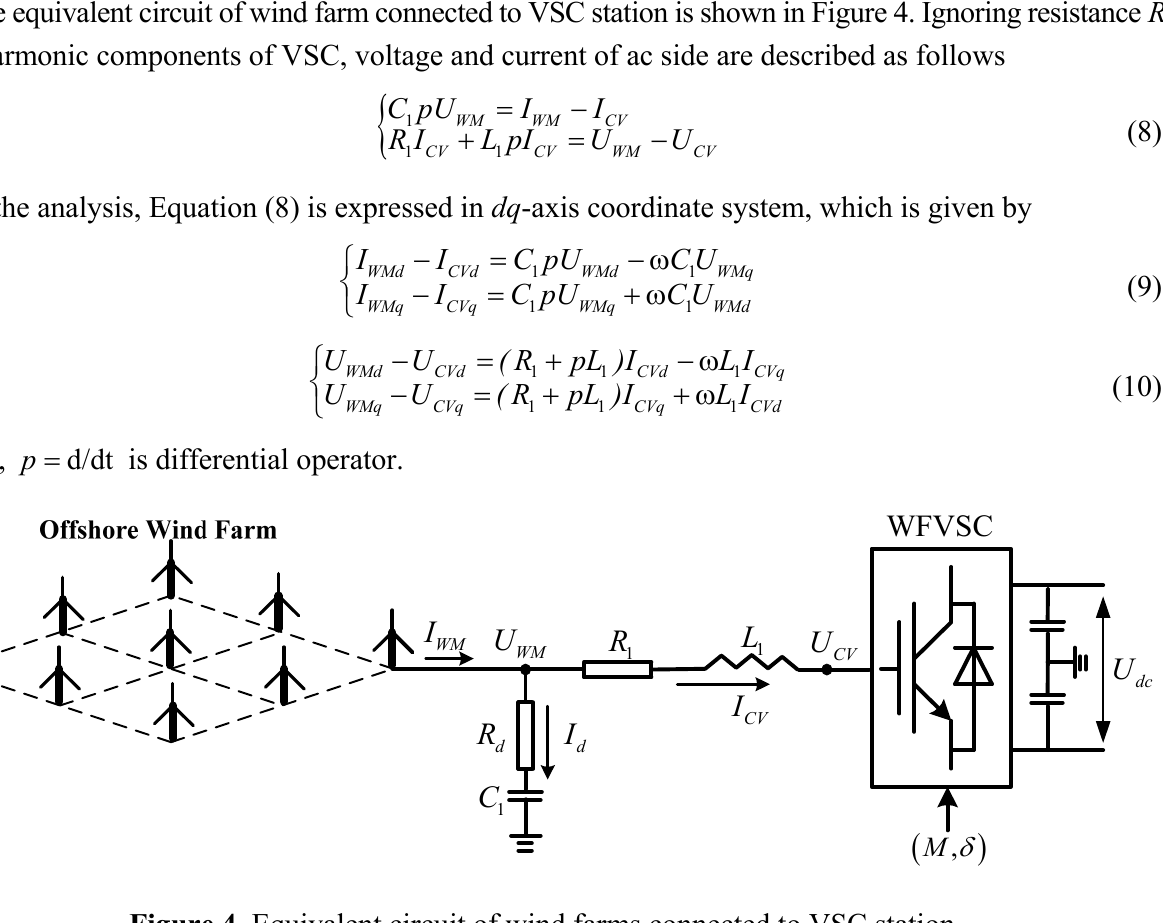
Figure 4. Equivalent circuit of wind farms connected to VSC